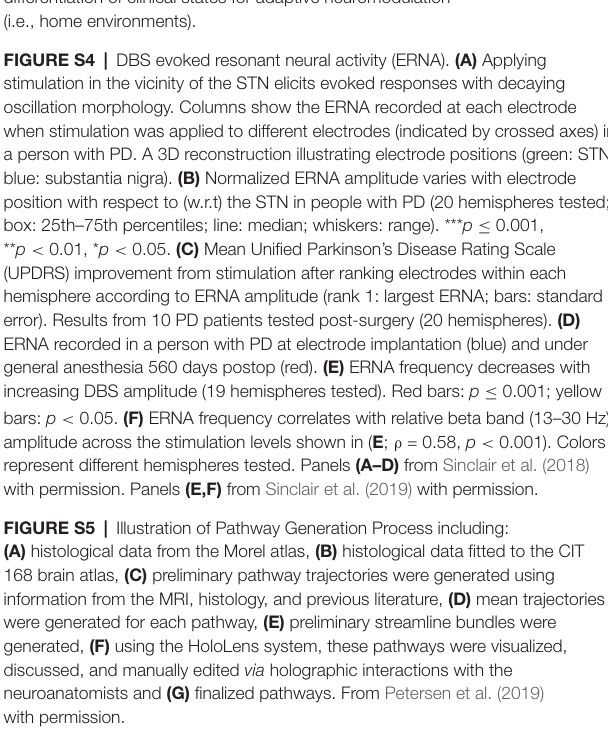
FIGURE S1 | Adaptive Deep Brain Stimulation (aDBS) relies on identifying unique neurophysiological biomarkers using local field potentials (LFPs) at the cortical (using Ecog) or subcortical (through the DBS lead) level to trigger and deliver stimulation using an advanced sensing device (for additional details please refer to main text).